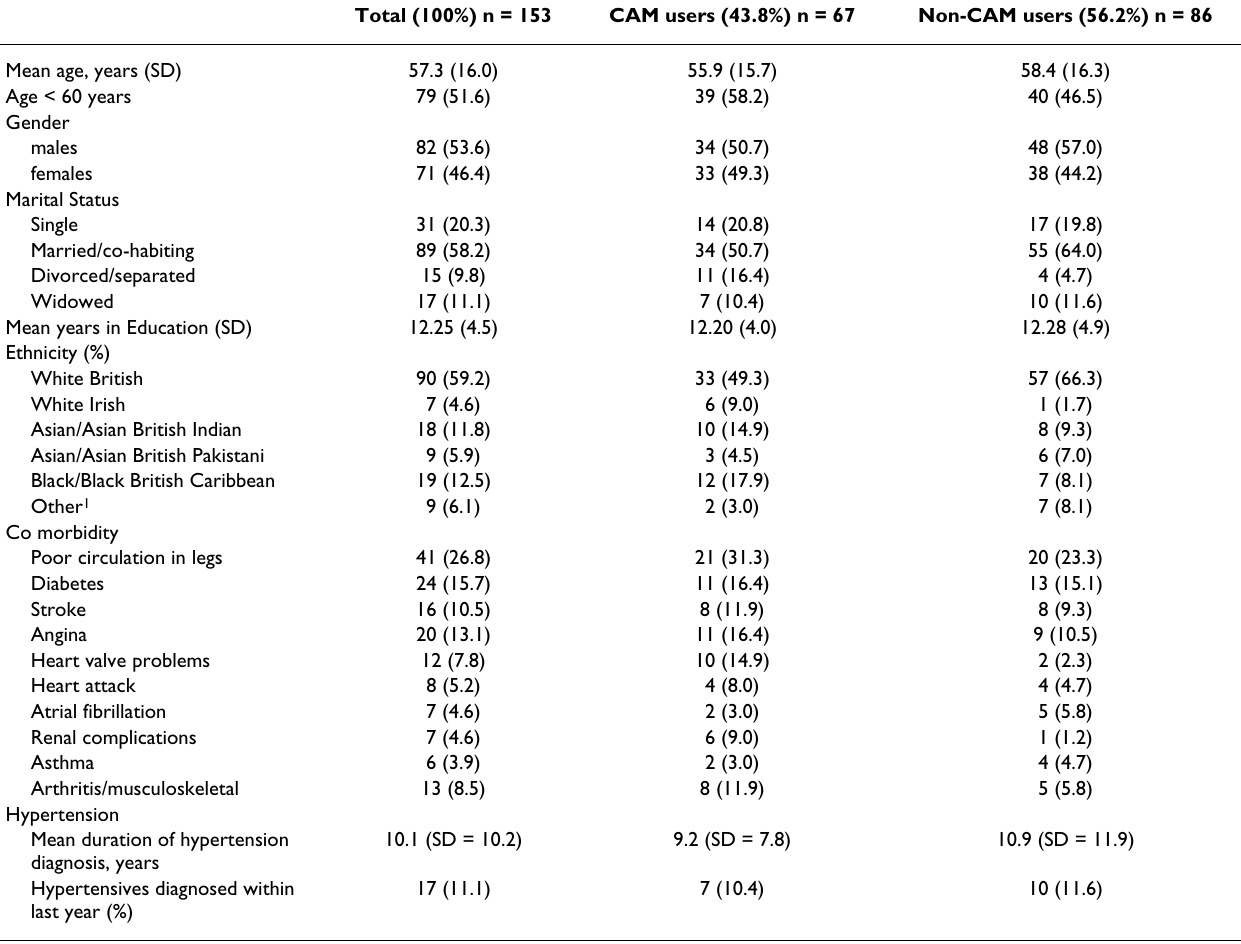
Table 1: Characteristics of respondents: users and non-users of CAM Total (100%) n =